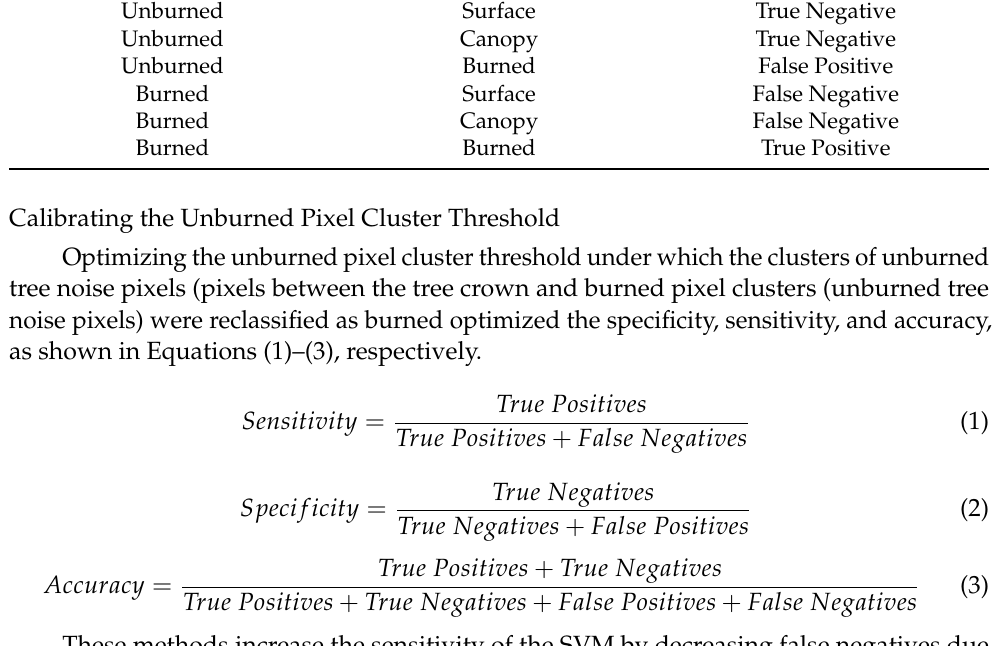
Table 2. Assignment of Classification Values to Confusion Matrix Categories. Human